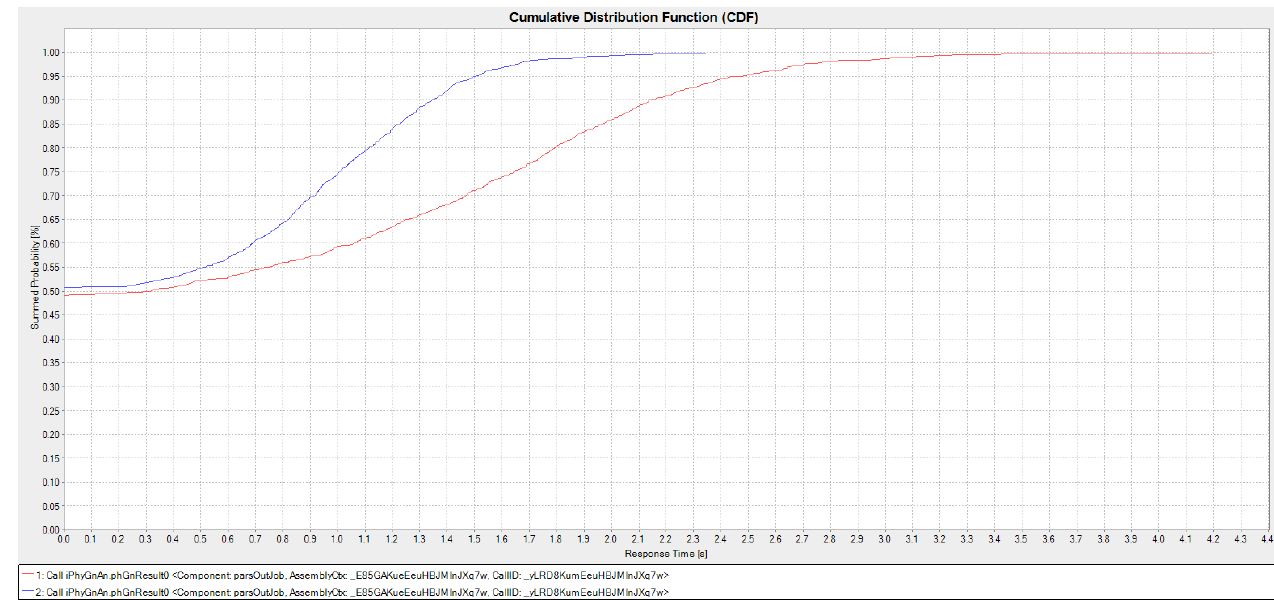
Figure 12. Comparison between the response time of the phGnResult function from the original architecture (red curve) and the alternative design (blue curve).